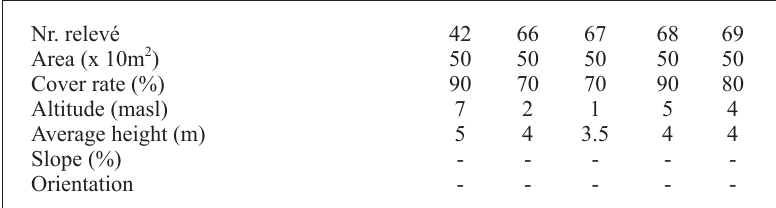
TABLE VII Lycio americani-Prosopidetum juliflorae ass.